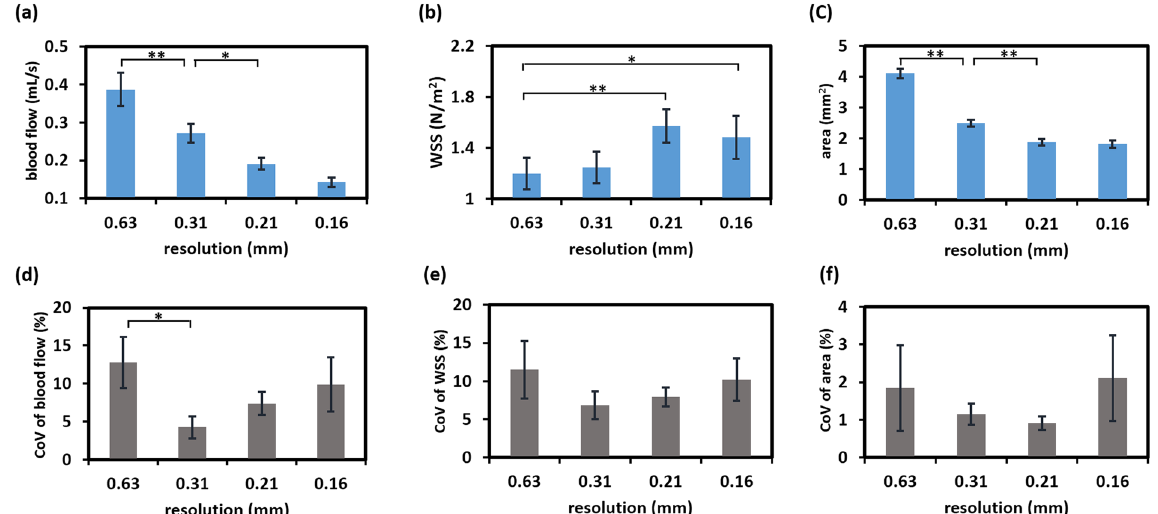
Figure 4. Effects of different in-plane resolution values on ( a ) blood flow, ( b ) WSS, ( c ) artery area, and their corresponding CoVs [( d ),( e ) and ( f ), respectively]. * P < 0.05, ** P < 0.01.